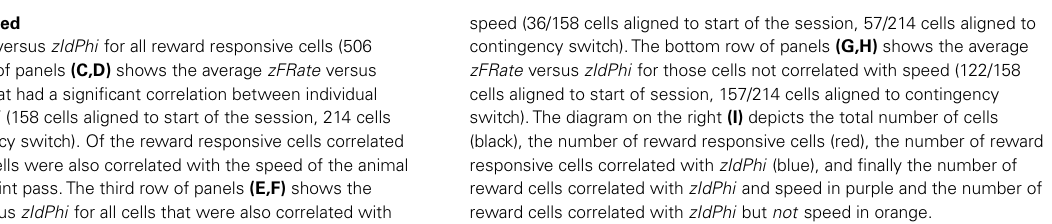
FIGURE 9 | Continued the average zFRate versus zIdPhi for all reward responsive cells (506 cells).The next row of panels (C,D) shows the average zFRate versus zIdPhi for all cells that had a significant correlation between individual firing rate and zIdPhi (158 cells aligned to start of the session, 214 cells aligned to contingency switch). Of the reward responsive cells correlated with zIdPhi , some cells were also correlated with the speed of the animal during the choice point pass.The third row of panels (E,F) shows the average zFRate versus zIdPhi for all cells that were also correlated with